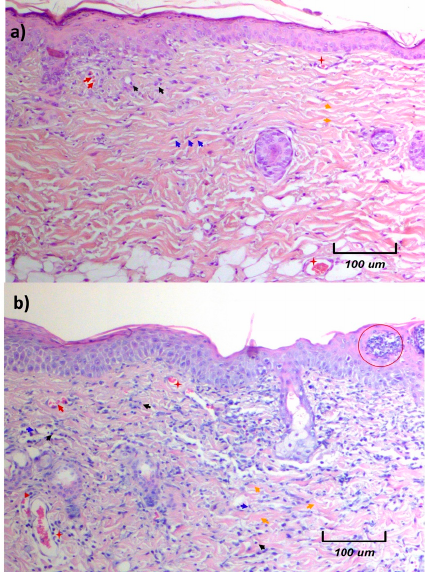
Figure 1. Histology of skin samples obtained from sites with different treatments on day 3. Samples were stained with hematoxylin and eosin (H&E). ( a ) Control samples of untreated healthy skin. ( b )